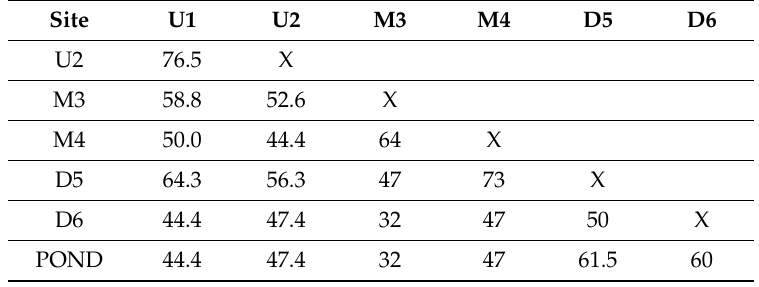
Table 3. Taxonomic similarity of macroinvertebrates between sites (Jaccard’s